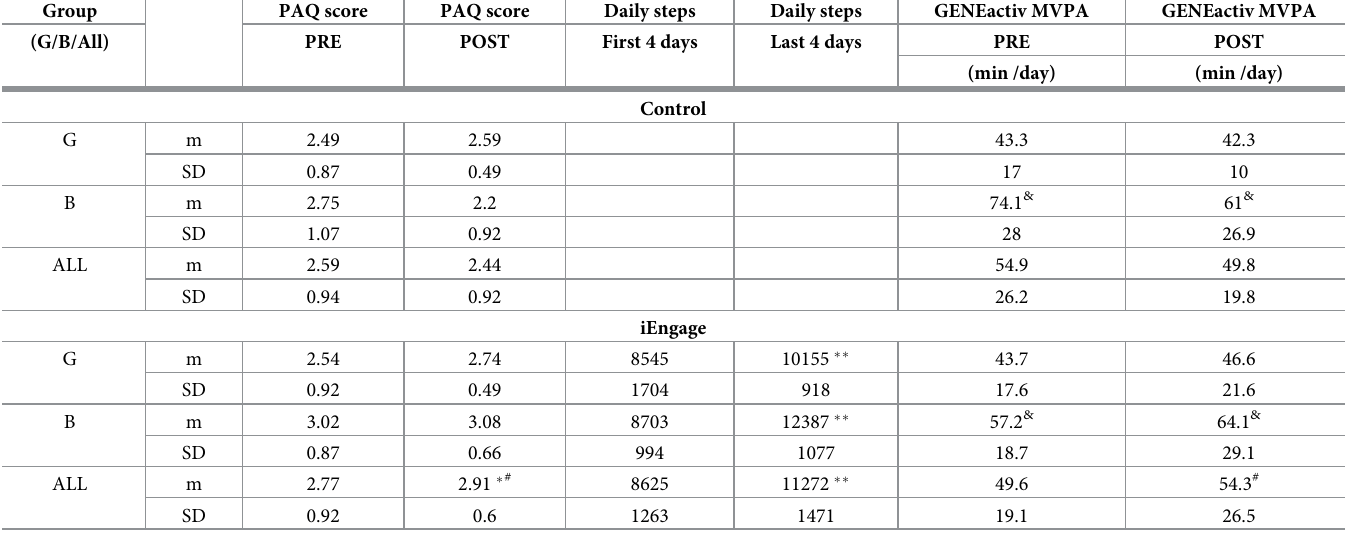
Table 2. Physical activity assessed via physical activity questionnaire (PAQ), daily steps via wrist step tracker Misfit and moderate to vigorous physical activity (MVPA) assessed using GENEactiv wrist accelerometer. Group PAQ